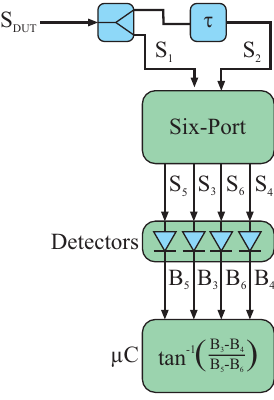
Figure 14. Six-port system for interferometric frequency